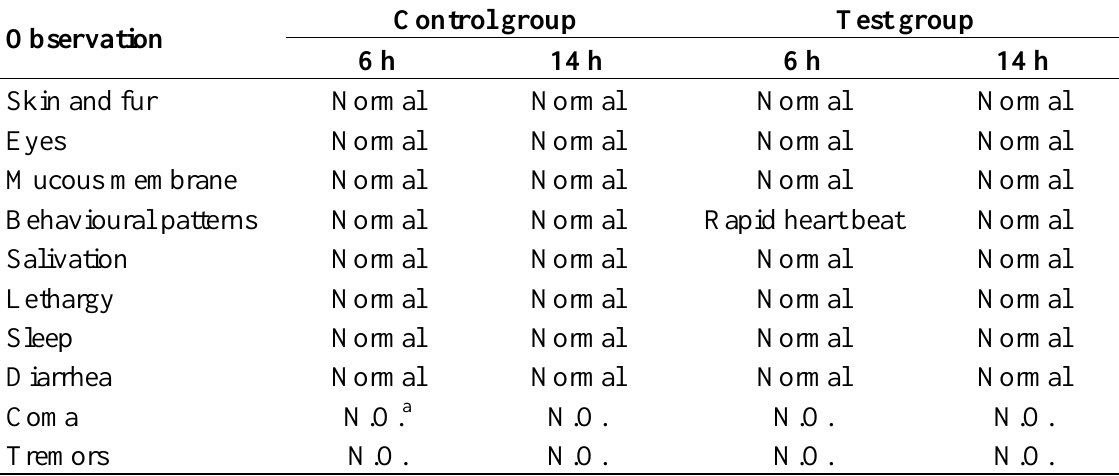
Table 2. General appearance and behavioral observations for control and treated